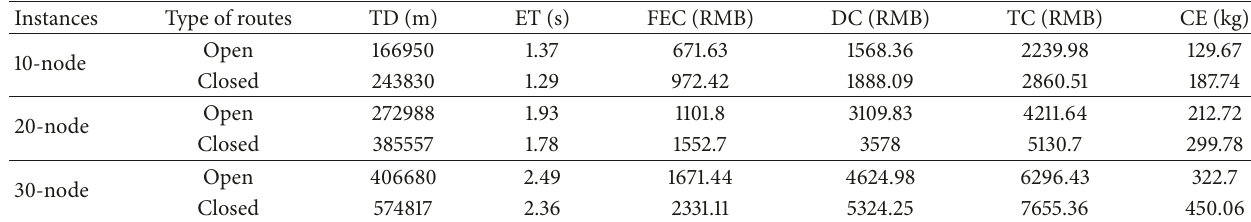
Table 9: Cost components of different types of